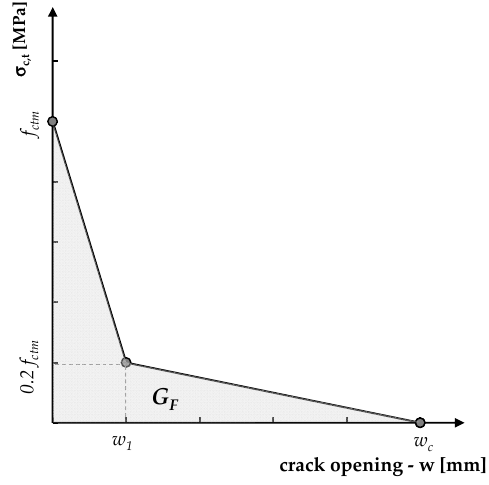
Figure 5. Stress-crack opening relationship for cracked concrete.